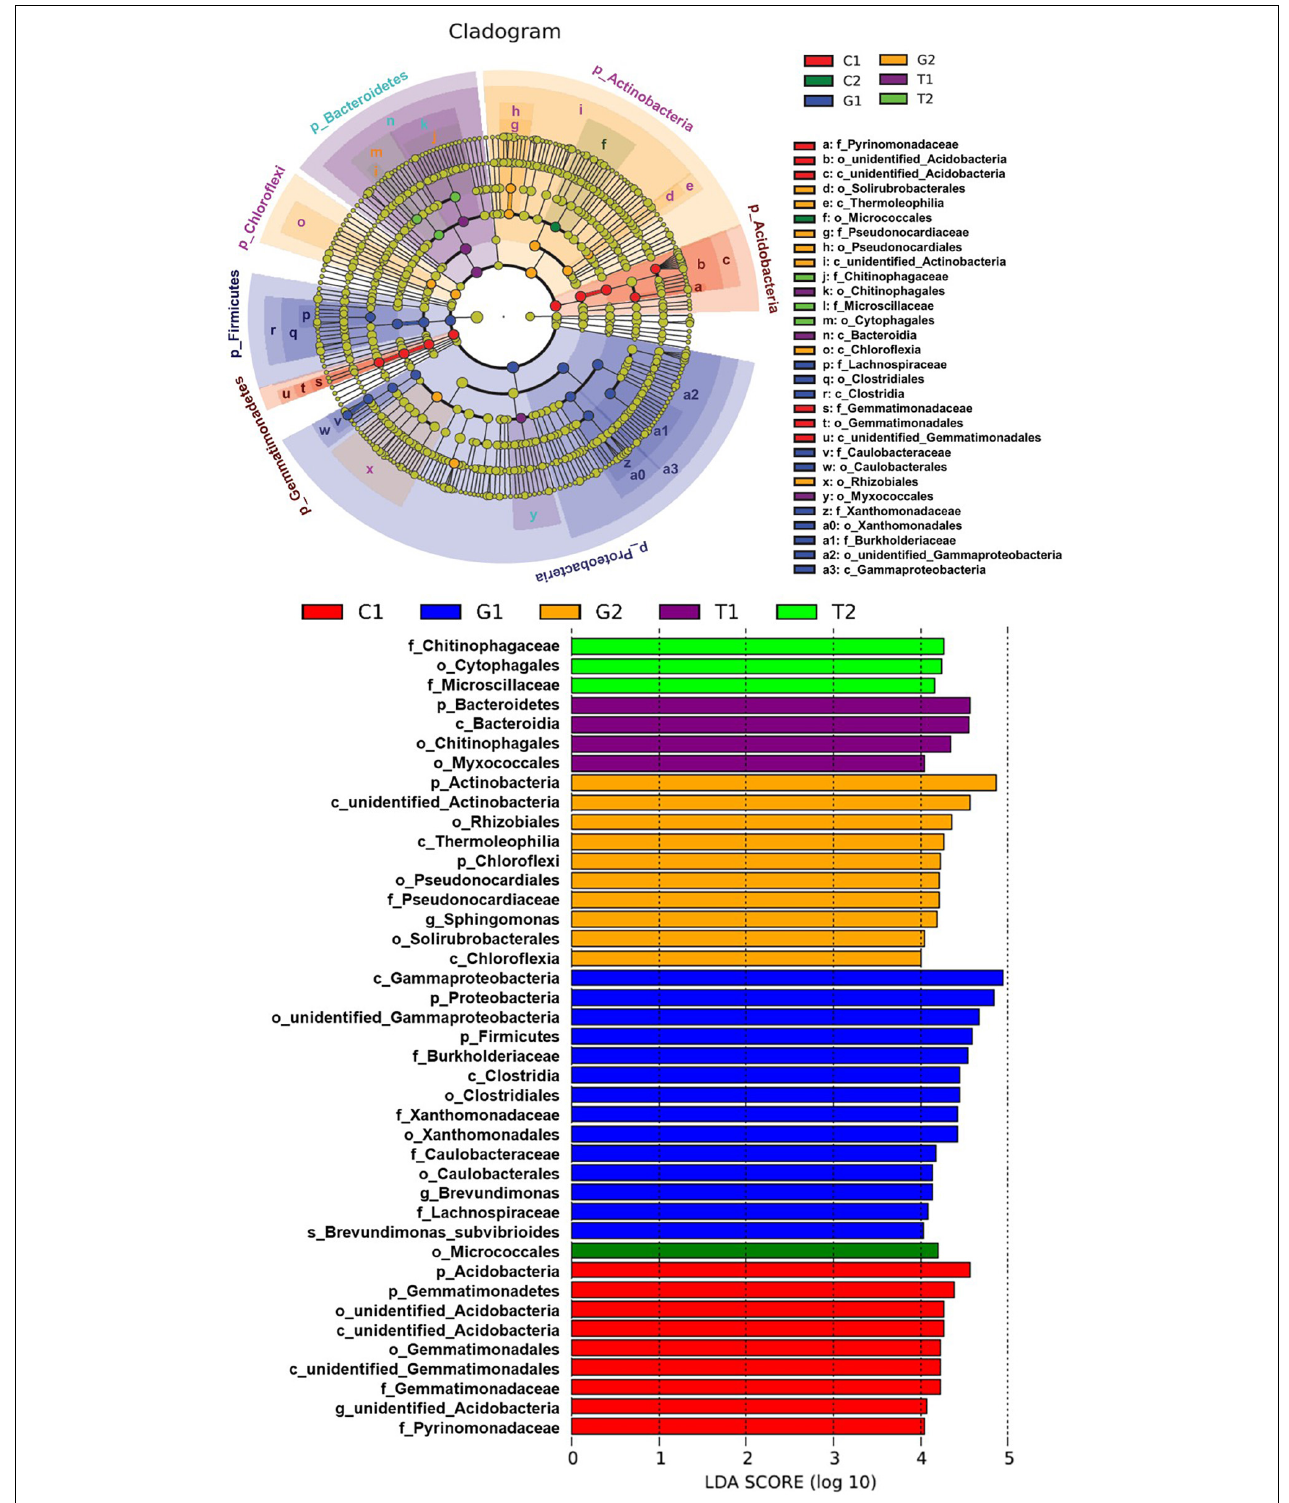
FIGURE 5 | Linear discriminant analysis (LDA) effect size (LefSe) analysis of soil microbial abundance. C1: cultivated land with distance to river from 100 to 200 m; C2: cultivated land with distance to river from 300 to 500 m; G1: grassland with distance to river from 100 to 200 m; G2: grassland with distance to river from 300 to 500 m; T1: forestland with distance to river from 100 to 200 m; T2: forestland with distance to river from 300 to 500 m.